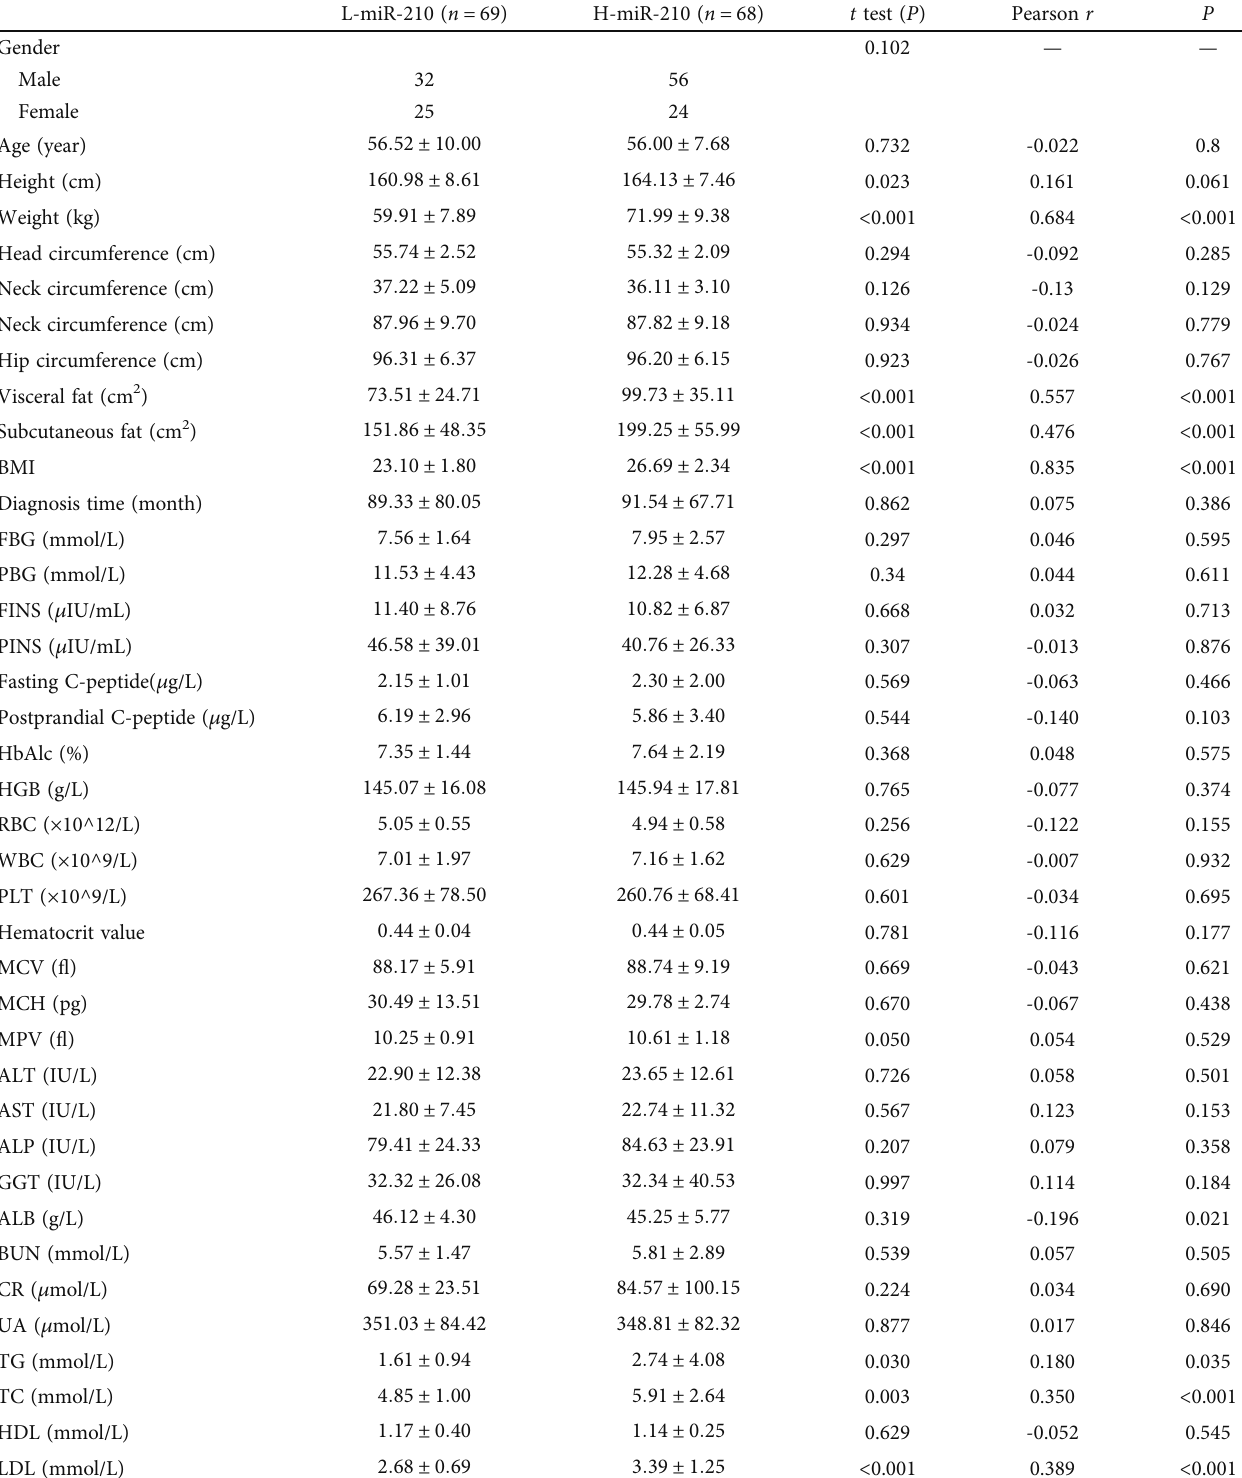
Table 3: The di ff erences and correlation of demographic, general, and clinical characteristics between high and low miR-210 level groups in patients with type 2 diabetes